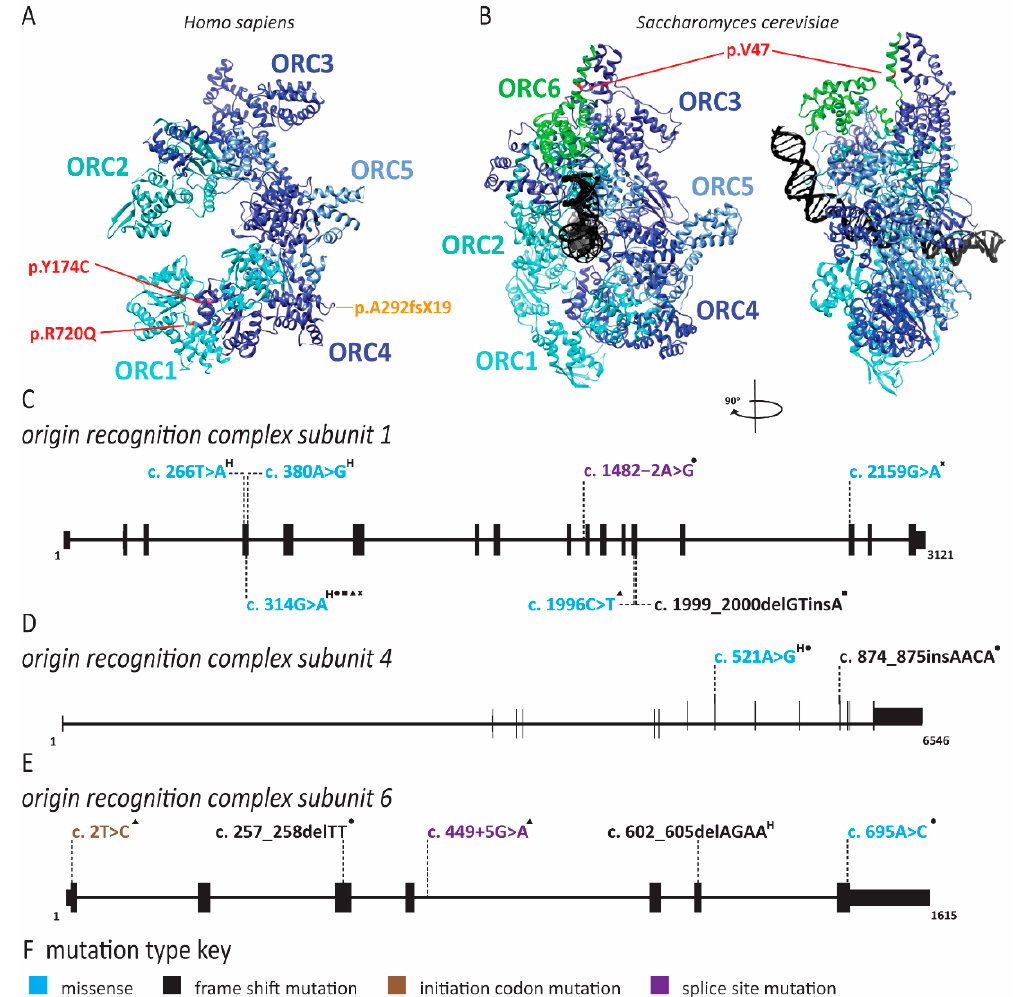
Figure 2. Mutations in origin recognition complex ( ORC ) subunits cause Meier-Gorlin syndrome. Pathogenic mutations in ORC subunits are depicted on a schematic of each gene and the crystal structure of either Homo sapiens or Saccharomyces cerevisiae proteins. Mutations that do not have corresponding amino acids in the structure or resulted in abnormal splicing are not depicted. For a complete list of mutations and associated protein changes, see Supplementary Table S1. Structures were generated with the Chimera program (http://www.cgl.ucsf.edu/chimera). Exon and intron schematics were generated with the UCSD genome browser. Reference sequences are ORC1 NM_004153.4, ORC4 NM_181742.4 and ORC6 NM_014321.4. ( A ) Crystal structure of human ORC subunits with mutations depicted, including missense mutations (red) and frame shift mutations (orange). The structure was generated using pdb file 5UJM. ( B ) Alignment of Homo sapiens and Saccharomyces cerevisiae ORC6 was completed using UniProt alignment tool (https://www.uniprot.org/align/). The amino acid corresponding to missense mutation p.Y232S (c.695A > C) is identified in red on the crystal structure of yeast ORC6. The structure was generated using pdb file 5zr1. Schematic of ( C ) ORC1 , ( D ) ORC4 and ( E ) ORC6 genes depicted with exons as black boxes and introns as horizontal lines. Mutations are mapped to the appropriate gene regions. “H” superscript indicates a homozygous mutation. Compound heterozygous mutation pairs are indicated by superscript symbols. Each mutation combination is depicted, and certain alleles may be present in multiple combinations such as ORC1 c.314G > A. The frequency of each allele in the affected population is not indicated. ( F ) For each gene, the color of the mutations indicates the type of mutation according to this key.